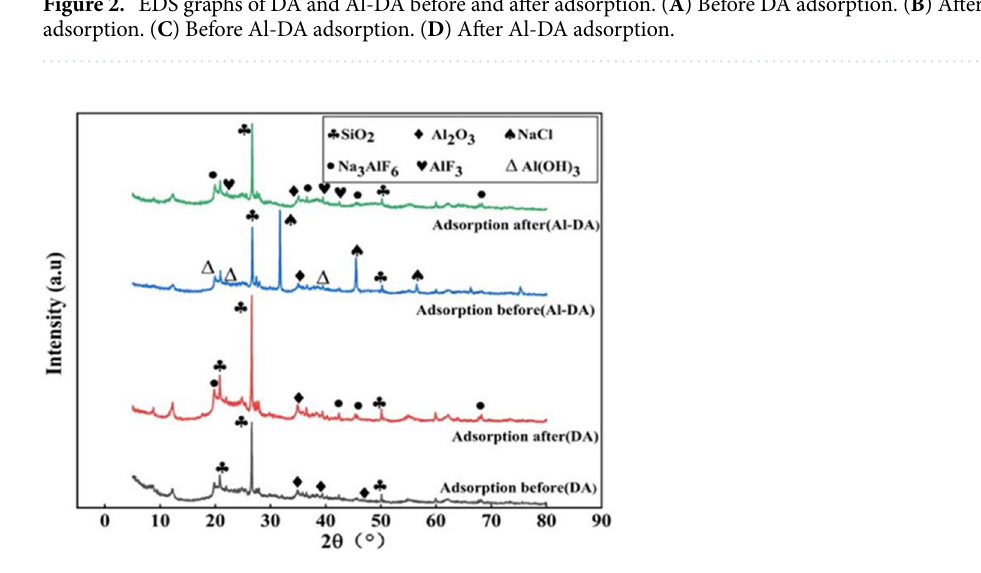
Figure 3. XRD patterns of DA and Al-DA before and after